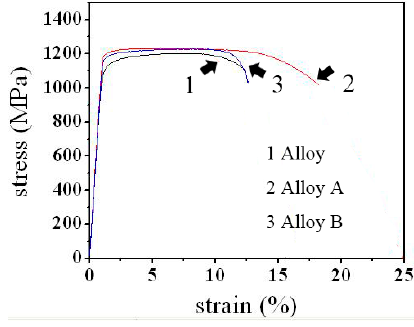
Figure 3. Stress-strain curves of the alloy, alloy A and alloy B.